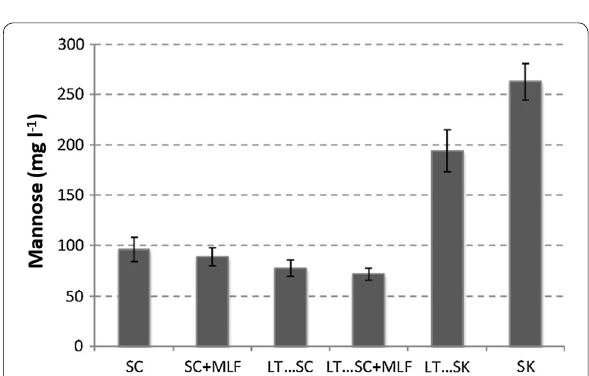
Fig. 2 Mannose released from polysaccharides after hydrolysis of wines fermented at microvinification scale with: S. cerevisiae 87 alone (SC), sequential fermentation with Saccharomyces cerevisiae 87 and L. thermotolerans CONCERTO ™ (LT…SC), sequential fermentation with S. pombe V2 and Lachancea thermotolerans CONCERTO ™ (LT…SK), S. pombe V2 alone (SK), and fermentations after malolactic fermentation with Oenococcus oeni 217 ( +